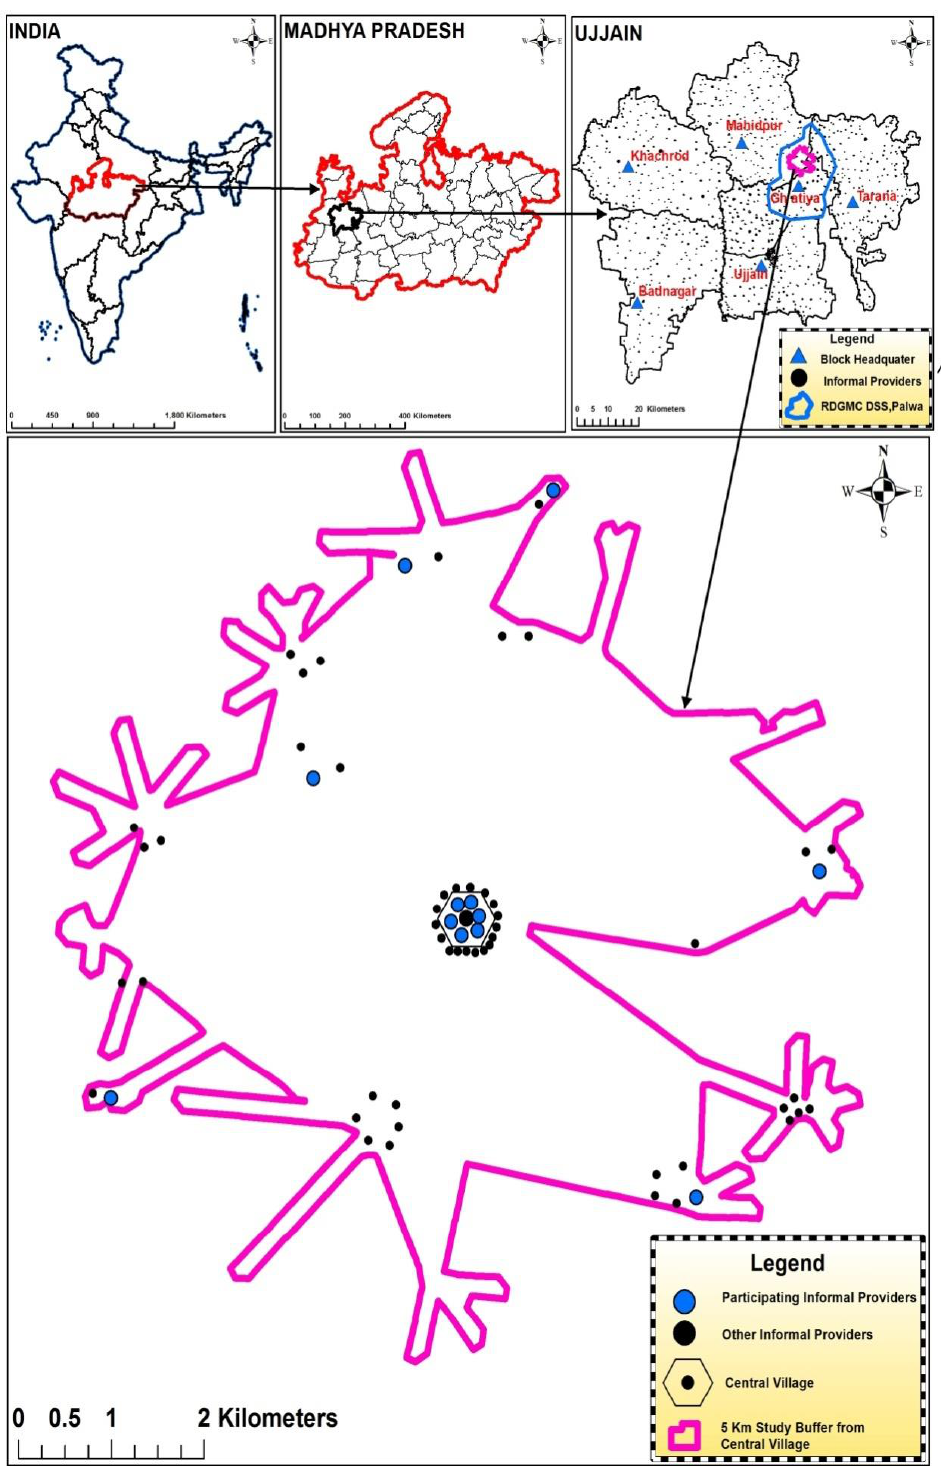
Figure 3. Geographical location of the selected informal healthcare providers. The maps show India, Madhya Pradesh, Ujjain district, and the location of participating informal healthcare providers within the sampling frame.